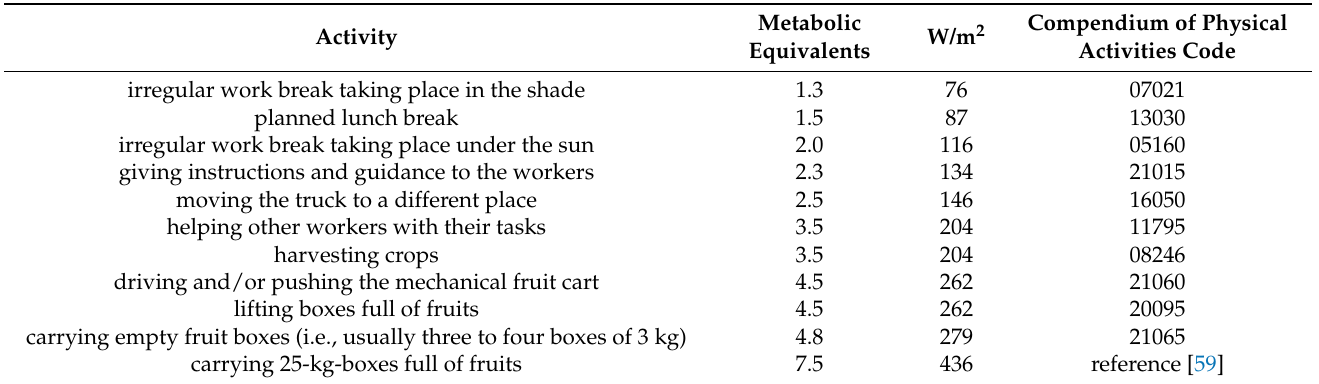
Table A1. Determination of the intensity of each work task on the basis of time-motion analysis.